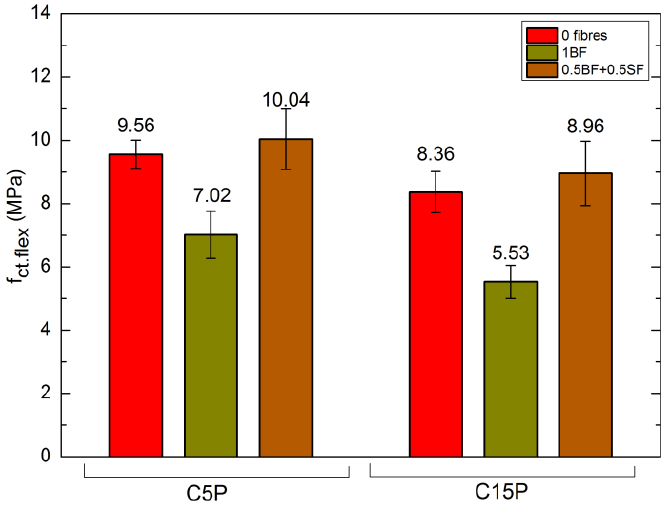
Figure 5. Flexural strength of SCLC after 28 days.